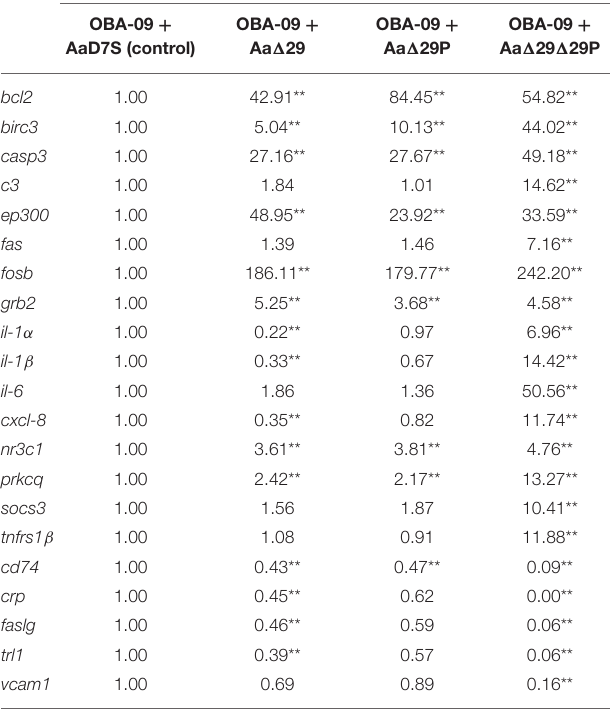
TABLE 2 | Inflammatory response of OBA-09 cell after 4h of interaction with Aa strains. Gene Mean of relative expression (2 − 11 CT method) in each interaction assay